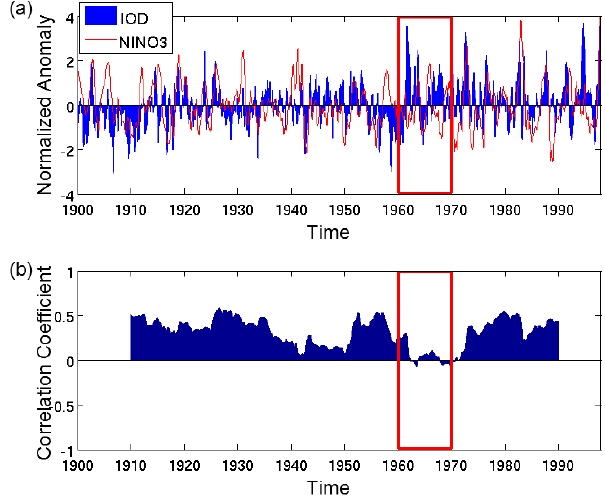
Fig. 1. (a) Normalised time series (mean zero and variance one) Fig. 1. (a) Normalized time series (mean zero and variance one) of IOD (from Japan Agency for Marine Earth Science and Tech- of IOD (from Japan Agency for Marine Earth Science and Technol- nology; http://www.jamstec.go.jp) and ENSO (from KNMI Climate ogy ( http://www.jamstec.go.jp )) and ENSO (from KNMI Explorer; http://climexp.knmi.nl) from 1900 to 1997. (b) Running Climate Explorer ( http://climexp.knmi.nl )) from 1900 to correlation coefficients between IOD and ENSO for the past 10yr at 1997 (b) Running correlation coefficients between IOD and ENSO all the time points. Both time series have been smoothed by using a for the past 10 years at all the time points. Both time series have 3-month moving average. The ENSO is represented by NINO3 sea been smoothed by using a 3-month moving average. The ENSO is temperature anomalies. By the red rectangles the 1960s is empha- represented by NINO3 sea temperature anomalies. By the red rect- sised, where the IOD index obviously exhibits a behaviour different angles the 1960’s is emphasized, where the IOD index obviously from that of ENSO in the 1960s and then the correlation between exhibits a behaviour different from that of ENSO in the 1960’s and them is low ( < 0 . 1) during this then the correlation between them is low ( < 0 : 1 ) during this time.